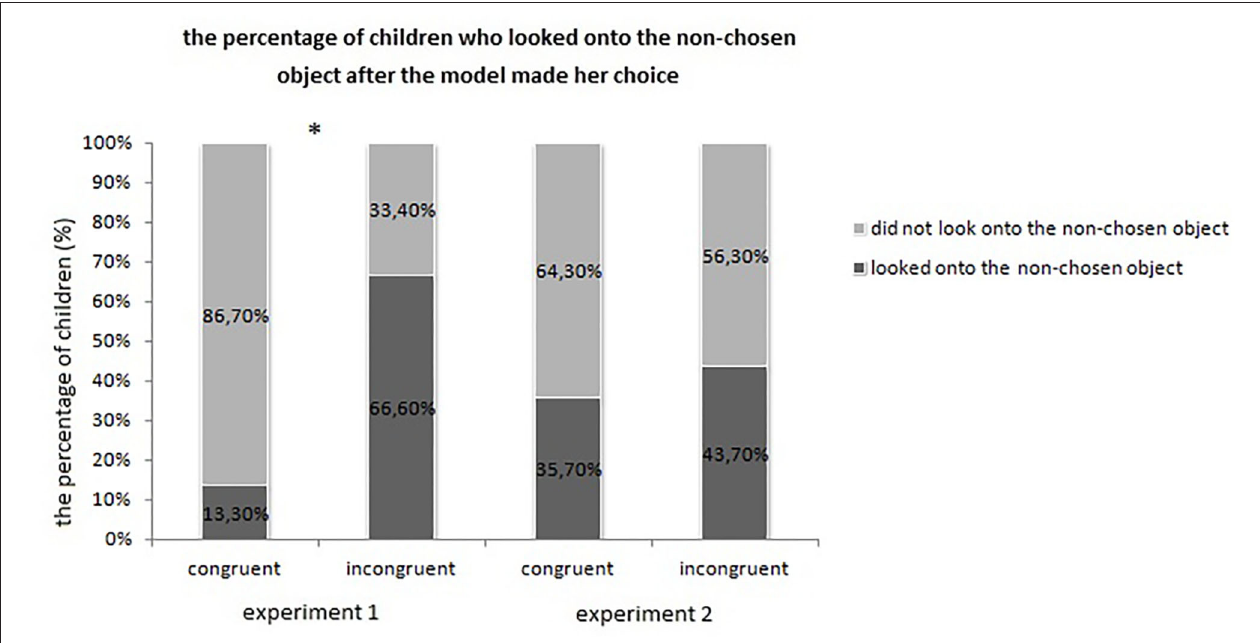
FIGURE 4 | Looking patterns of experiment 1 and 2. This graph depicts the percentage of children who looked onto the non-chosen object after the model made her choice. The asterisk indicates the significant different which was detected in case of Experiment